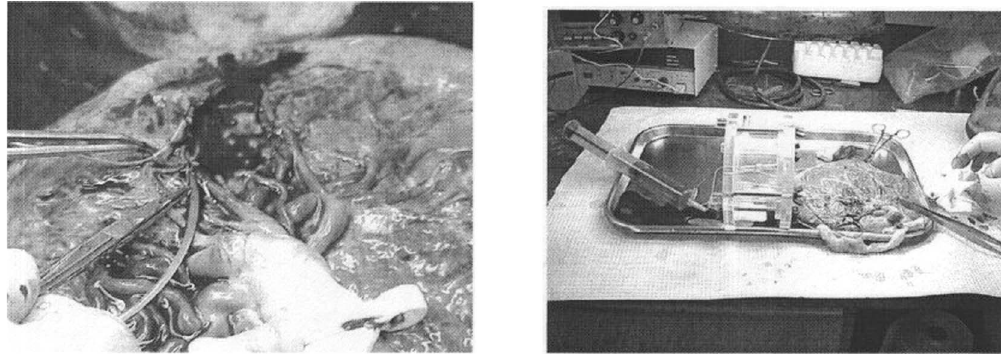
Figure 1. Fetal circulation. (a) Cannulization of vein. (b) Establishing fetal